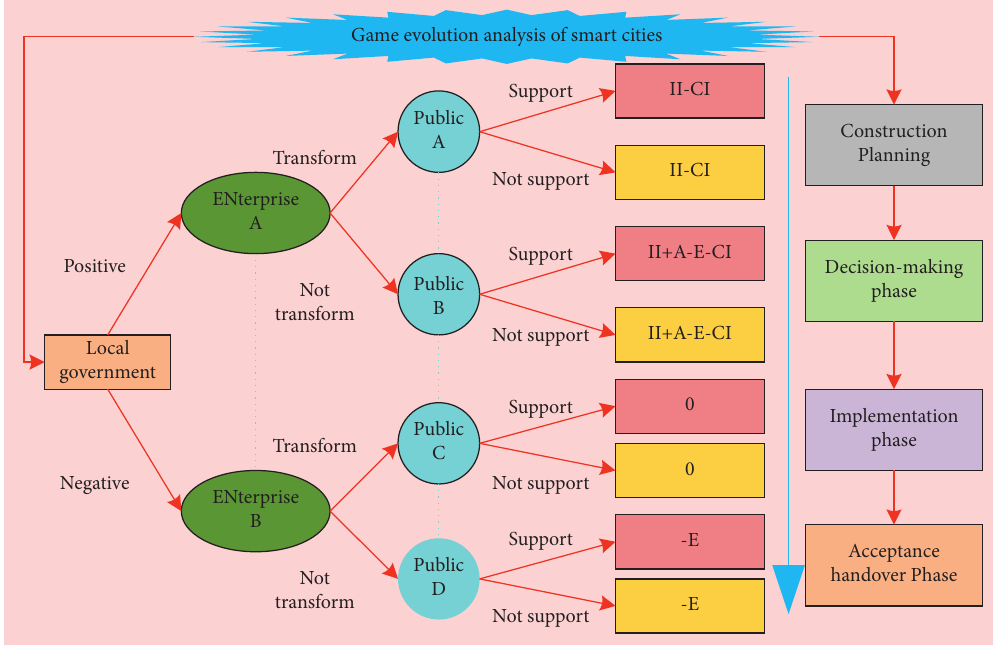
Figure 1: Gaming tree of revenue of smart city construction.